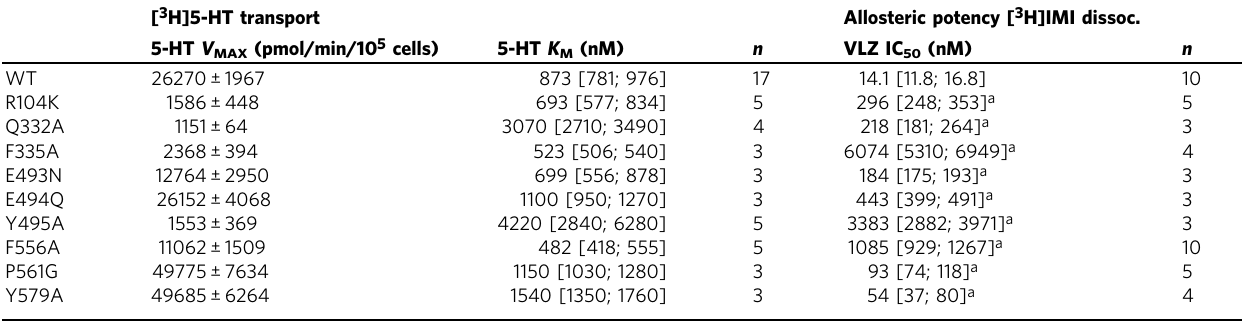
5-HT transport is performed on intact COS7 cells transiently expressing SERT WT or mutants. V MAX , and K M are calculated based on IC 50 and catalytic activity as described in “ Methods ” section. Cells are incubated with [ 3 H]5-HT for three minutes. VLZ is added 30min prior to [ 3 H]5-HT to obtain equilibrium. Values are calculated from non-linear regression analysis of [ 3 H]5-HT uptake and [ 3 H]IMI dissociation data. Data are shown as mean and either±S.E. (for V MAX ) or [S.E. interval], the latter calculated from pIC 50 ±S.E. Uptake experiments are performed in triplicates. Allosteric potency is calculated from a dose-dependent inhibition of [ 3 H]IMI dissociation from SERT (see Methods). a Signi fi cantly different from allosteric potency for SERT WT ( P <0.0001, Ordinary one-way ANOVA with Tukey ’ s multiple comparisons conformational equilibrium of SERT. All of the mutants showed a 200 ns of all atom molecular dynamics (MD) simulations of the fi nal re fi ned SERT structures with IMI and VLZ bound at their decreased allosteric potency relative to SERT WT, consistent with an impairment of VLZ binding. The decrease in allosteric potency binding sites, either in the hypothesized or fl ipped pose (Fig. 5). ranged from ~4-fold for Y579A to 430-fold for the F335A mutant (Table 1). The mutants fall into three categories with respect to their effect: F579A and P561Q exhibit less than 7-fold decrease in allosteric potency. An intermediary group of R104K, Q332A, E493N, and E494Q show a 13- to 30-fold decrease in potency, whereas F335A, T495A, and F556A have 77-, 240- and 430-fold decrease, respectively. The fold change in allosteric potency is not only dependent on the interaction of the residue and VLZ, but also on the ability of the substituted residue to compensate for the WT environment. The isolated contribution of each residue might deviate somewhat from the observed af fi nity changes.